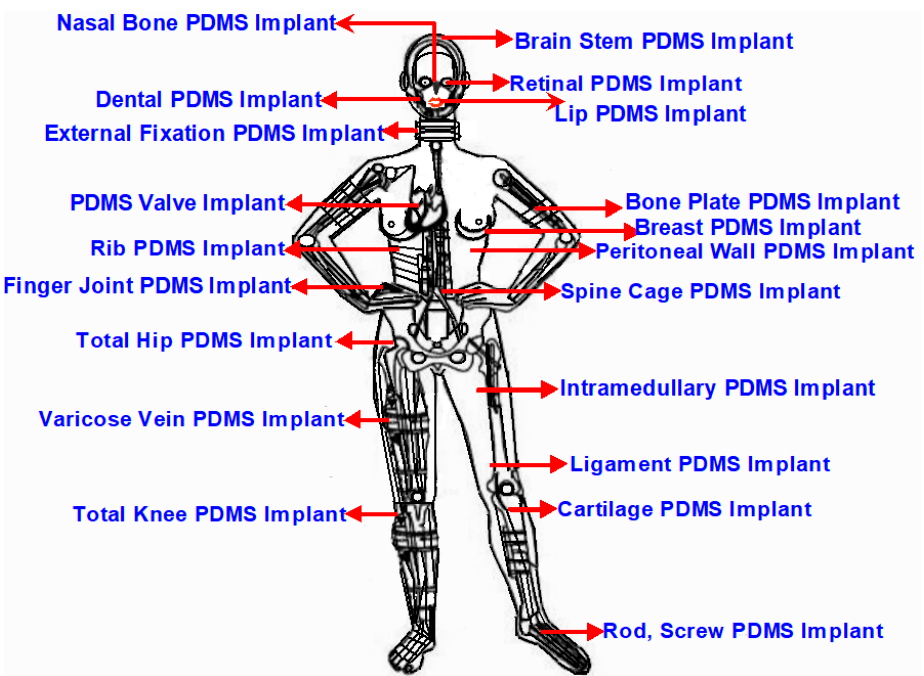
Figure 2. Possible PDMS-based Implants in the human body.